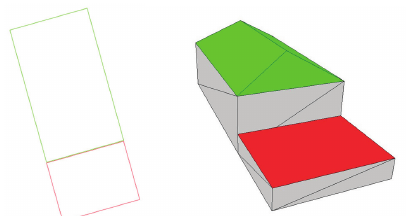
Figure 9. Enrichment of cadastral maps with different roof heights and